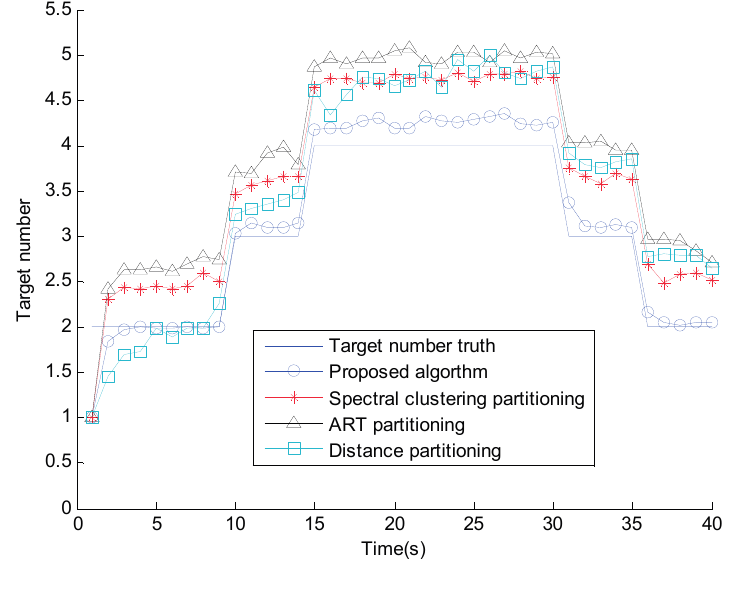
Figure 4. Target number